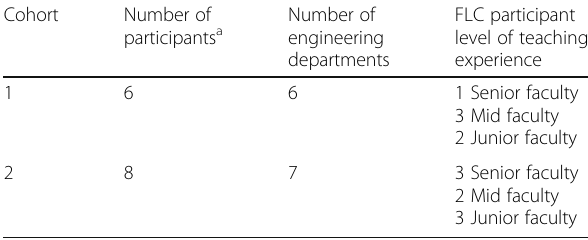
Table 1 Description of FLC cohort